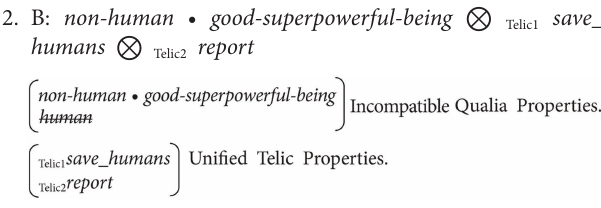
FIGURE 2 | The isomorphism between (a subpart of) a i …a k from A and (a subpart of) c i ...c k from